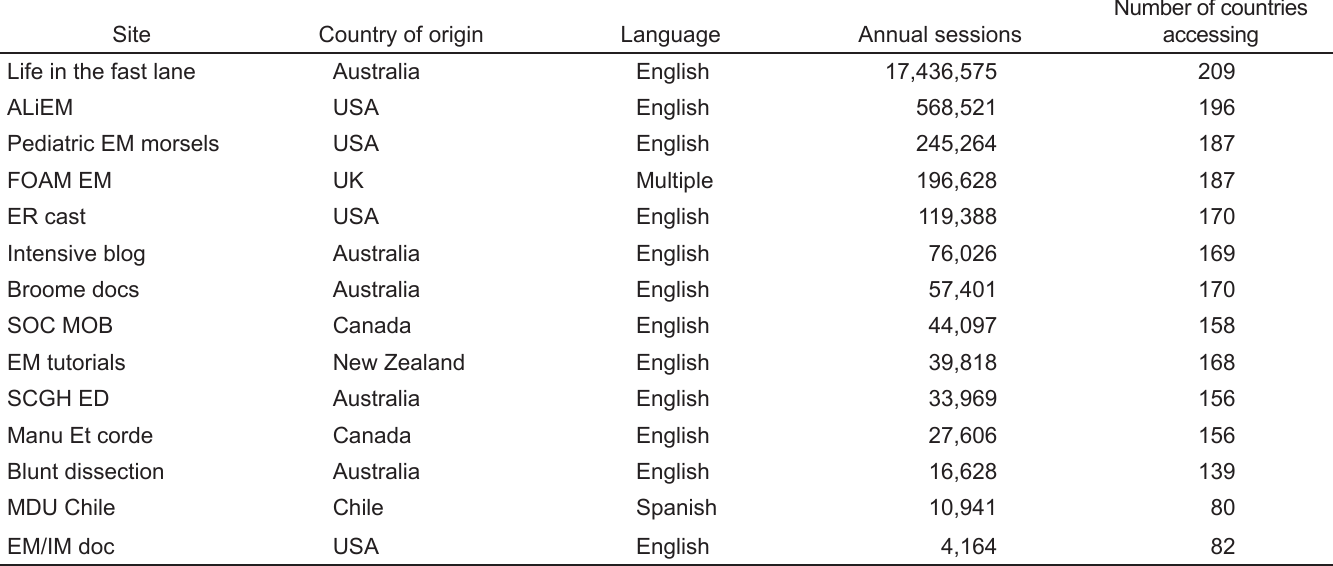
Table 1. Description of FOAM blogs and websites included for analysis, 2016.